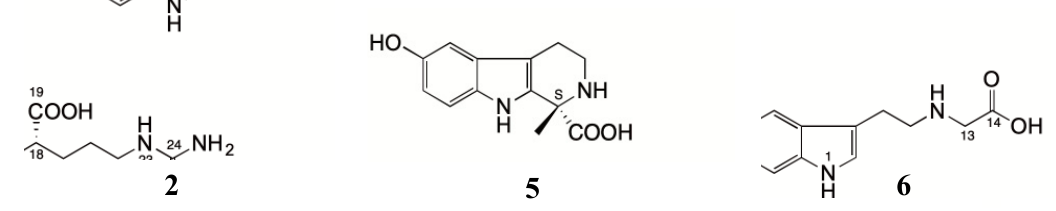
Figure 2. Key HMBC correlations of compounds 2 , 5 and